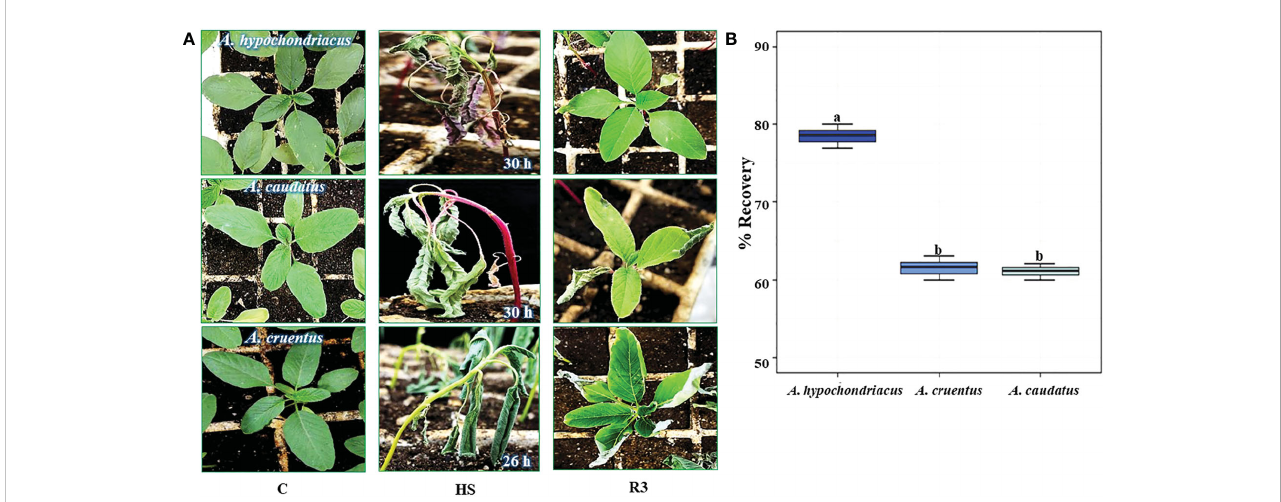
FIGURE 2 Heat shock tolerance of young grain amaranth plants. (A) Young grain amaranth plants, at the vegetative 1 stage of development, were placed in growth chamber and subjected to different heat shock (HS) periods, at 45°C and constant light: 30 h ( Amaranthus hypochondriacus and ( A caudatus ) and 26 h ( A. cruentus ). The aspect of the stressed plants (HS, middle panel) was compared with untreated control, (C) , plants maintained in optimal growing conditions (left-hand panel) and with plants that recovered from HS, shown after a 3-day period in optimal conditions (R3, right-hand panel). (B) The box-and-whisker plots show the percentage of recovery recorded in each of the three grain amaranth species analyzed. Different letters over the box-and-whisker plots, showing high, low, and median values, represent statistically signi fi cant differences; one-way ANOVA and Tukey Kramer test , P < 0.05 (n =